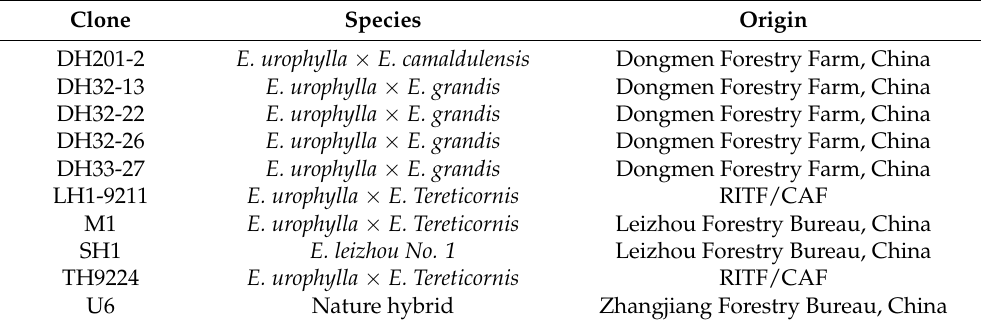
Table 2. Parentage of studied Eucalyptus